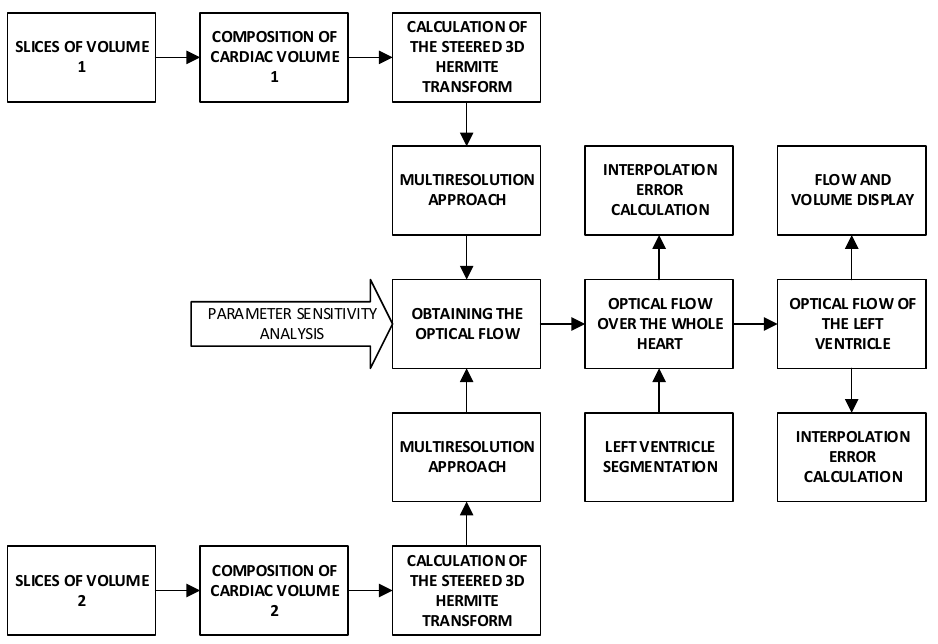
Figure 1. Overview of the proposed